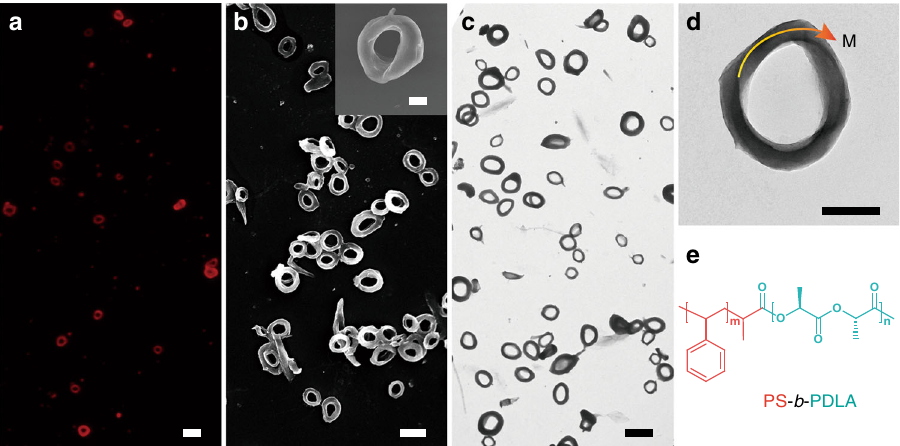
Fig. 1 Block copolymer Moebius strips. a Fluorescence microscopy (FM) image of fl uorescence dye-labeled PS- b -PDLA toroidal micelles. Nile red (<0.001 wt%) was added to the BCP solution prior to addition of water. b SEM and c TEM images of the PS- b -PDLA toroidal micelles. Inset in ( b ) and ( d ) are representative magni fi ed SEM and TEM image of the M-twisted PS- b -PDLA Moe b ius strip. e Chemical structure of the PS- b -PDLA. Scale bars: 2 μ m in ( a – c ); 500 nm in ( d ) and inset of ( b